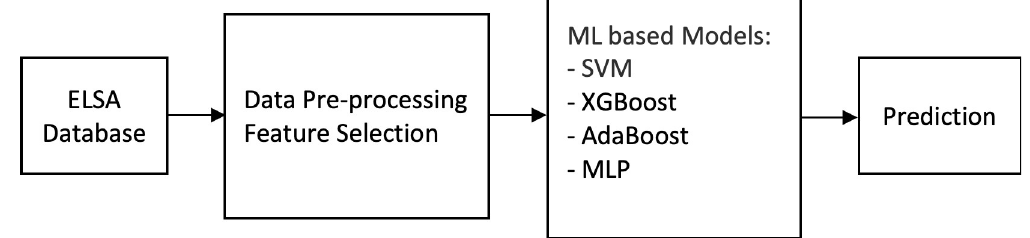
Fig 2. Framework of the proposed machine learning prediction